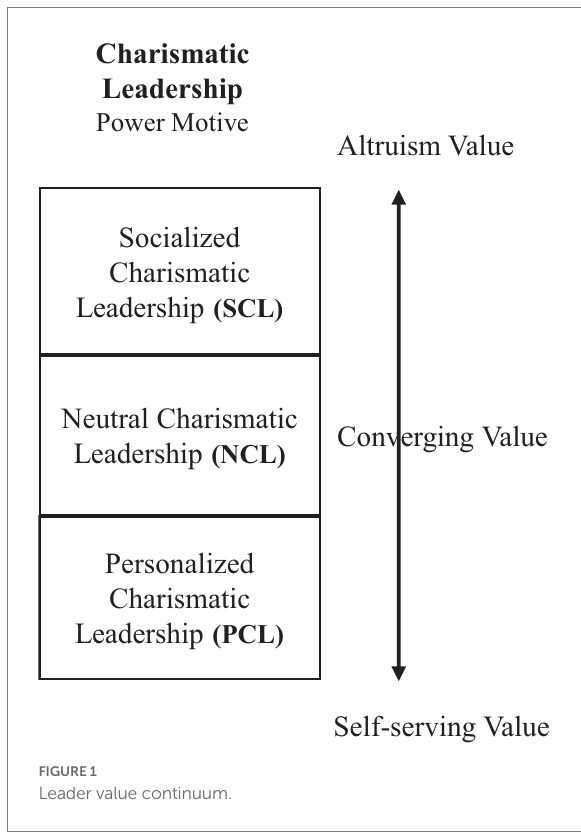
FIGURE 1 Leader value